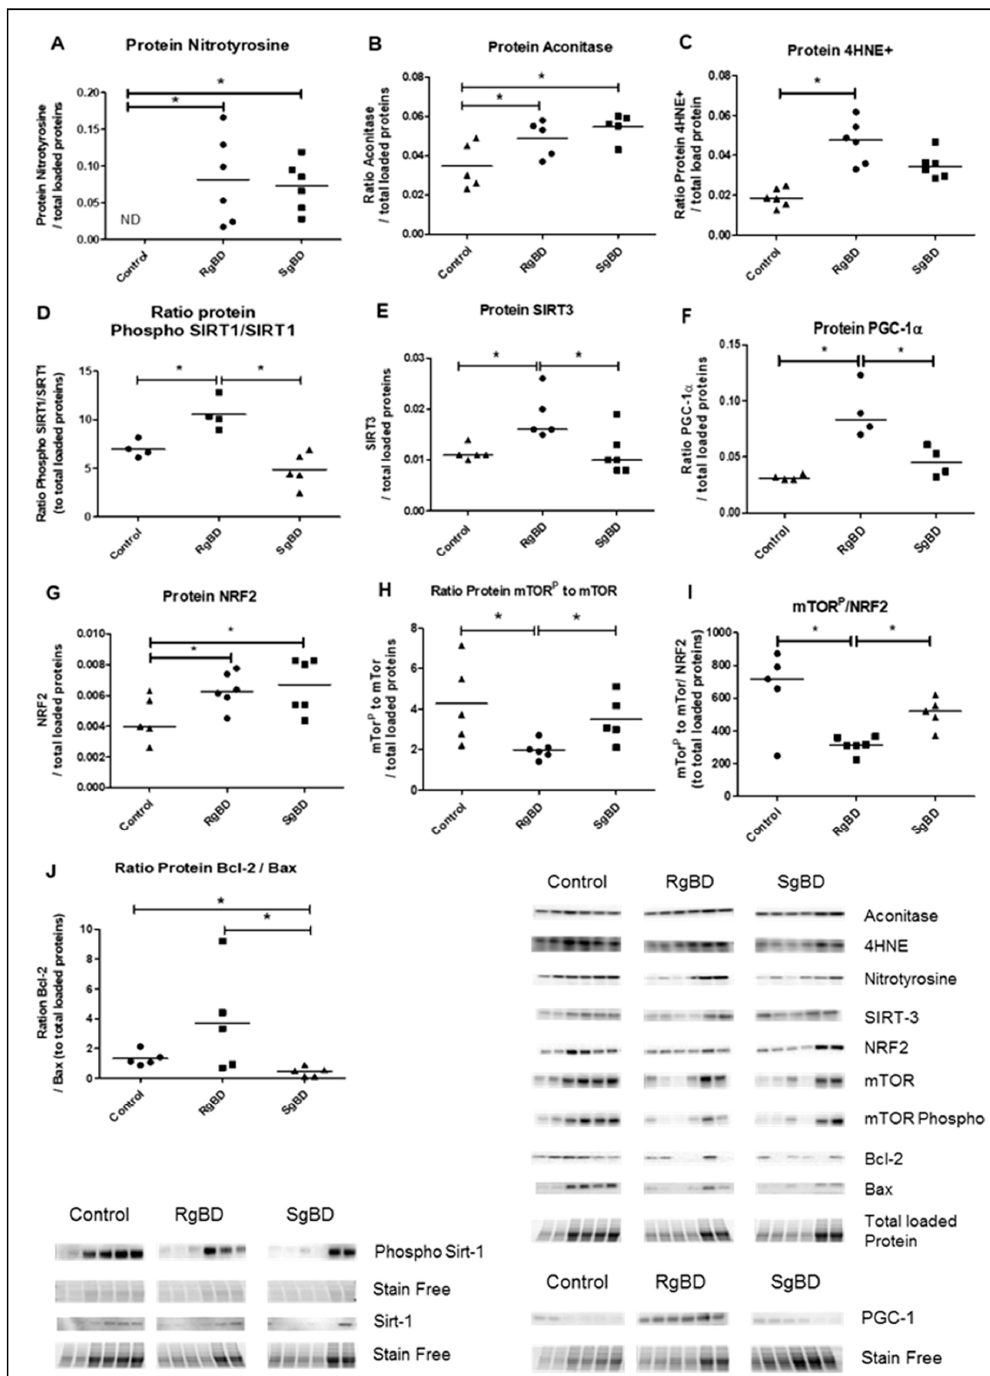
Figure 4. Donor management: Oxidative stress and response to oxidative stress by SIRTs-PGC-1a-NRF2-mTOR path and mitochondrial integrity at the end of reanimation. Protein expression level of nitrotyrosine ( A ), aconitase ( B ), 4HNE ( C ), ratio phosphorylated SIRT-1 to total SIRT-1 ( D ), SIRT-3 ( E ), PGC-1a ( F ), NRF2 ( G ), ratio phosphorylated mTOR to total mTOR ( H ), ratio phosphorylated mTOR to NRF2 ( I ) and ratio Bcl2 to Bax ( J ), evaluated by western blot at the end of 4 h donor management in renal tissue of rapid brain death induction (RgBD) and slow brain death induction (SgBD) groups versus control kidney ( n = 5–6 per group). Results are expressed in a scatter plot with the median, statistical analysis was performed with a Kruskal–Wallis multiple-comparison Dunn’s test. * p <